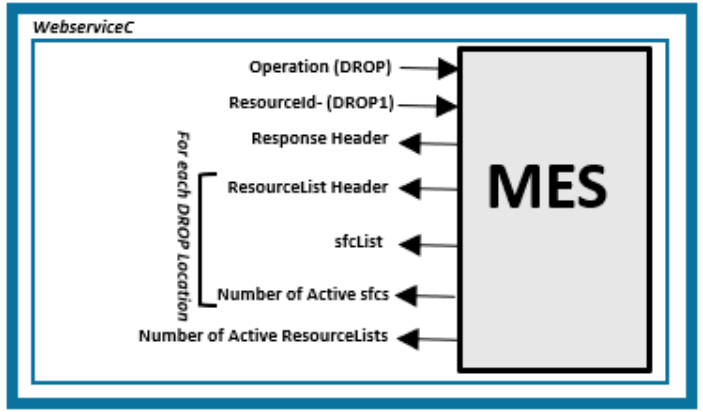
Figure 14. Check status of drop ‐ off locations.